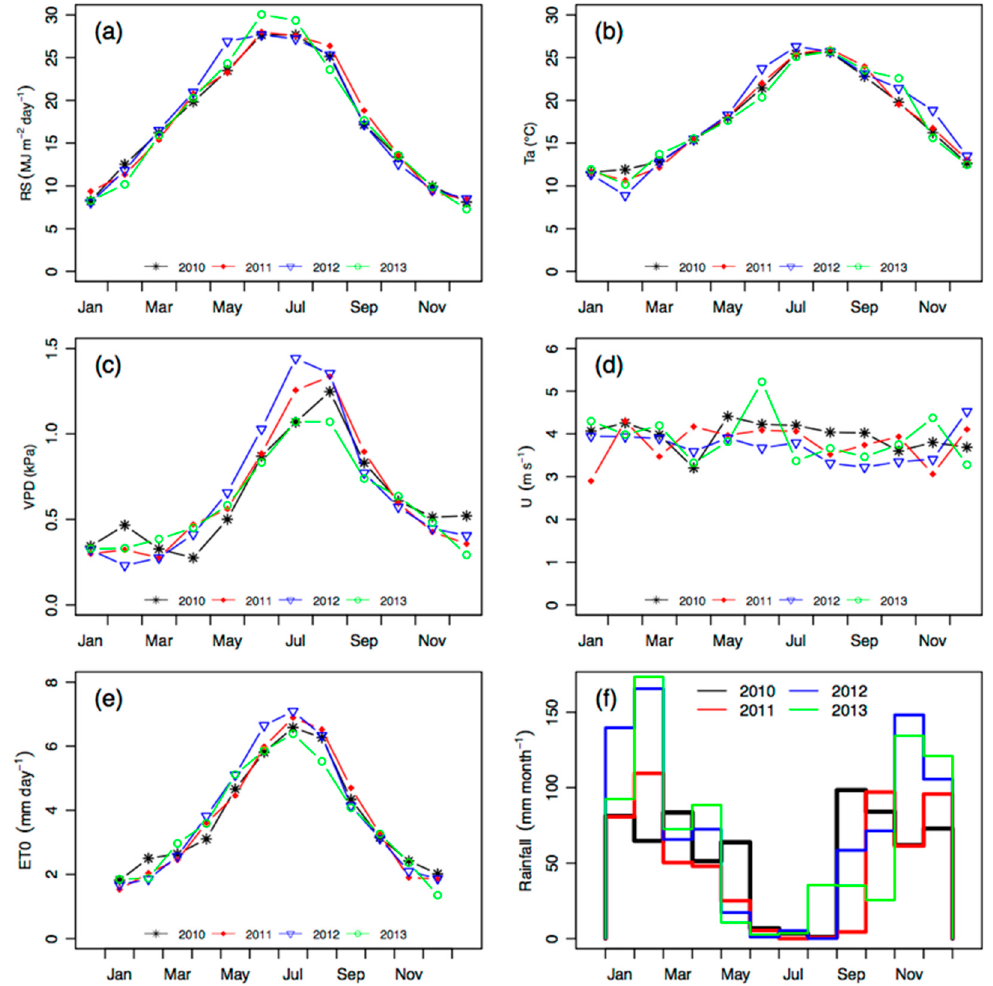
Figure 2. Climatic conditions during the four years of the experiment, recorded at the meteorological station: ( a ) Incoming solar radiation; ( b ) air temperature; ( c ) water vapor deficit; ( d ) wind speed; ( e ) reference evapotranspiration; ( f ) rainfall amounts. Values in ( a ) to ( e ) are the monthly averages, values in ( f ) are cumulated rainfall amounts.